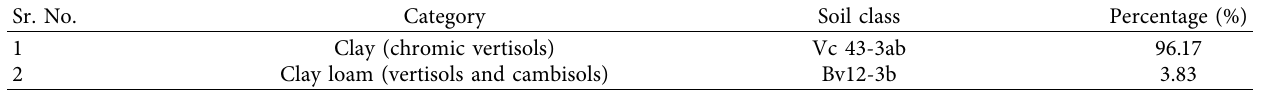
Table 2: Soil type for Kannad taluka.